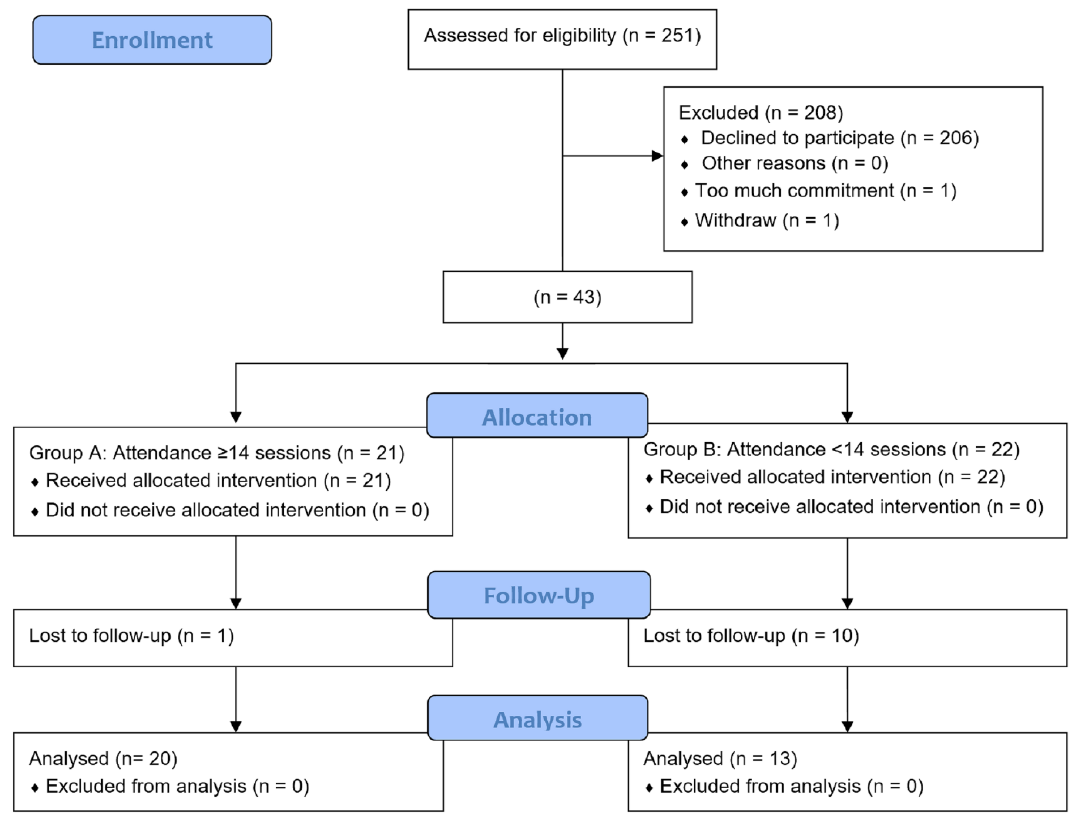
Figure 1. CONSORT flow diagram.